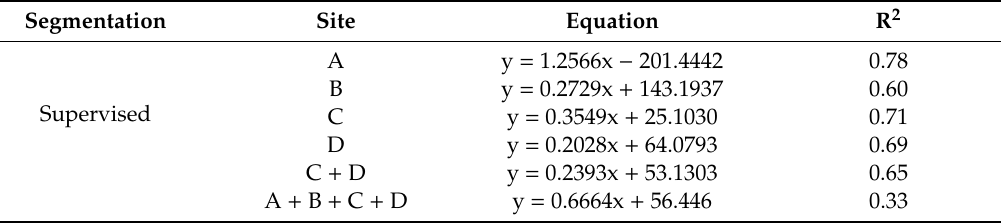
Table 5. Regression analysis between ground truth Wpw data (X-independent variable) and estimated projected crown volume reduction (Y-dependent variable) obtained by the application of supervised segmentation. Linear regression results (equation and R 2 ) calculated for each site (A, B, C, D) and aggregated dataset (C + D and A + B + C + D). All liner regressions provided significance results ( p < 0.001).